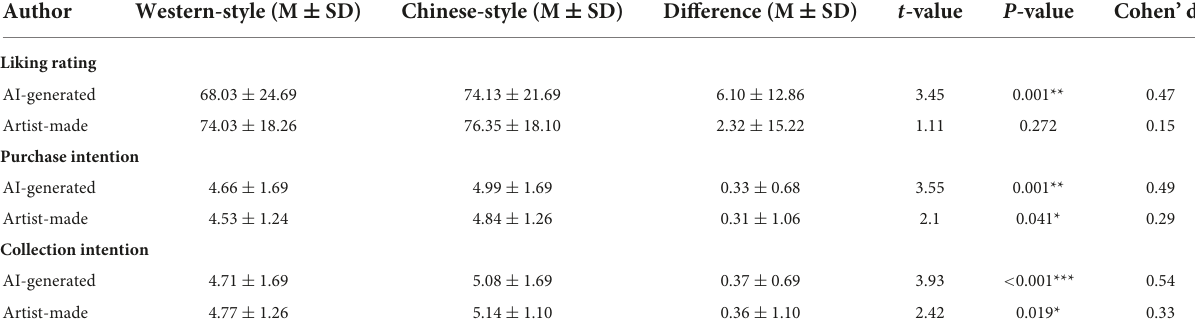
TABLE 1 Mean values of liking ratings, purchase intention, and collection intention toward paintings in different